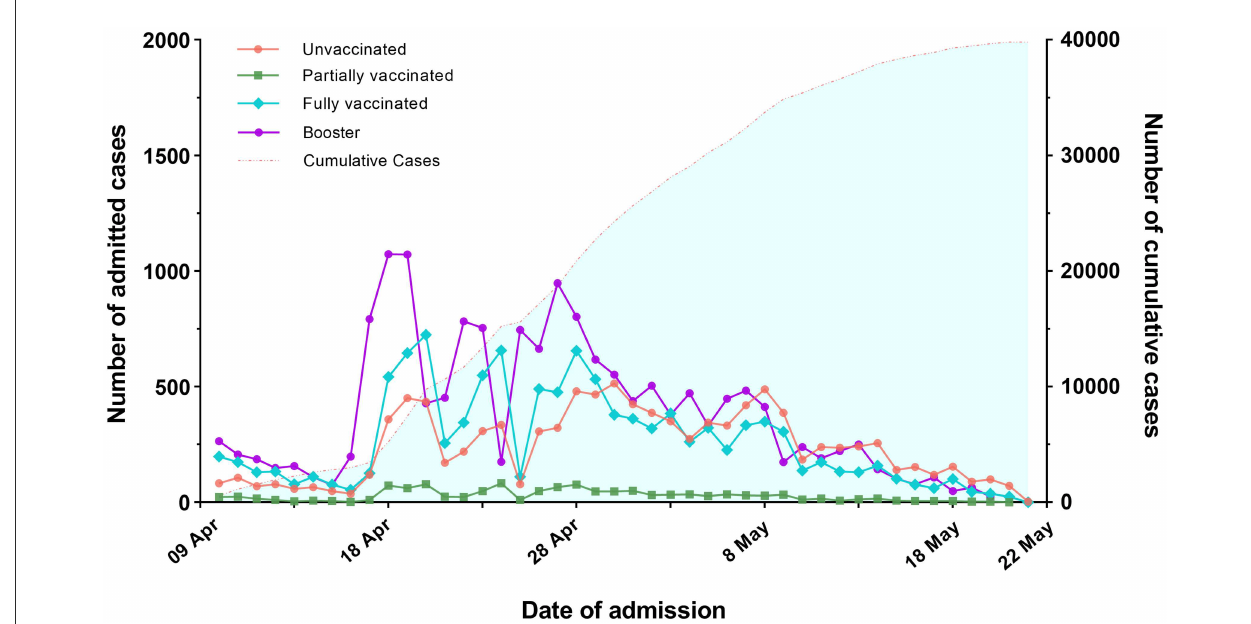
FIGURE1 Trends in the number of individuals admitted to the FSH among four types of vaccinations.